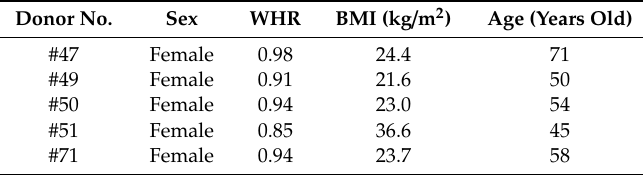
Table 1. Clinical information of donors for adipose tissue-derived stem cells